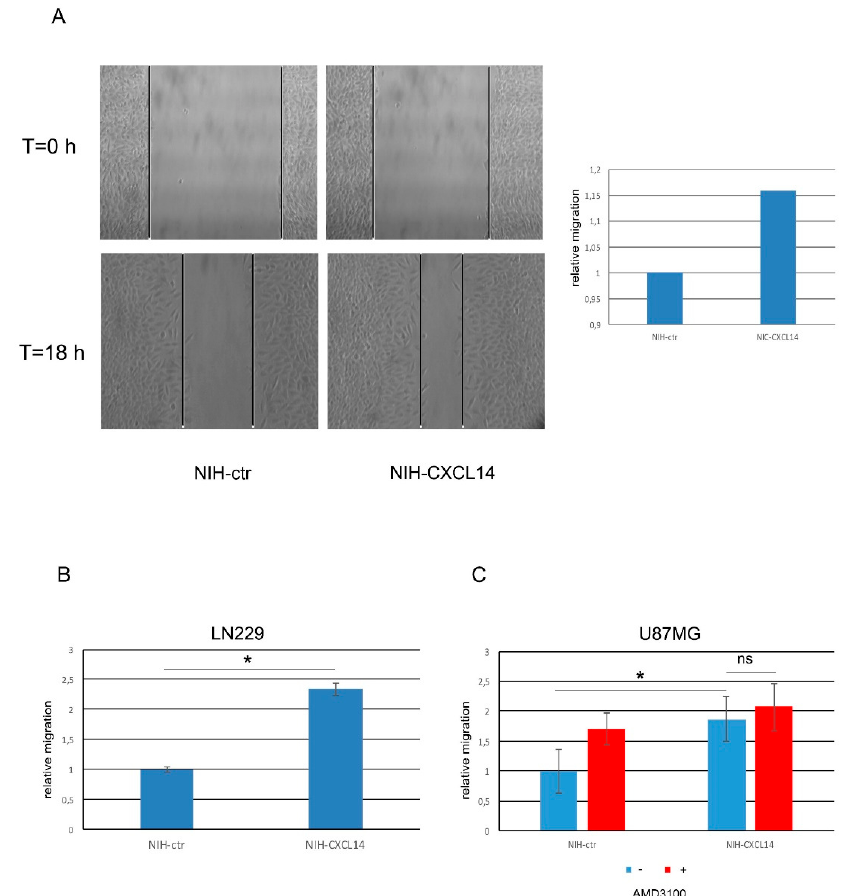
Figure 4. Exogenously supplemented CXCL14 increases the migratory ability of LN229 and U87MG glioblastoma cells. ( A ) Representative picture (left) and relative graphical visualization (right) of a scratch test assay measuring the migration ability of LN229 cells previously incubated with either NIH-ctr or NIH-CXCL14 conditioned medium. Pictures were taken at time 0, when the scratch was performed, and after 18 hours from scratching. In the graph, the distance migrated by cells in control conditions is set as = 1. ( B ) Migration transwell assays performed with LN229 cells after incubation with conditioned media of either negative control NIH-ctr or CXCL14 secreting NIH-CXCL14 cells. ( C ) Migration transwell assays performed with U87MG cells after incubation with conditioned media of either negative control NIH-ctr or CXCL14 secreting NIH-CXCL14 cells, with or without the supplementation of 10 µ M AMD3100. The graph shows the number of migrating cells as compared to negative control, set as = 1. Results are presented as mean ± S.D. with significant di ff erences from controls (*) shown ( p < 0.05). Two-tailed unpaired t -tests were used to determine significance between groups. The experiments were performed three times (biological